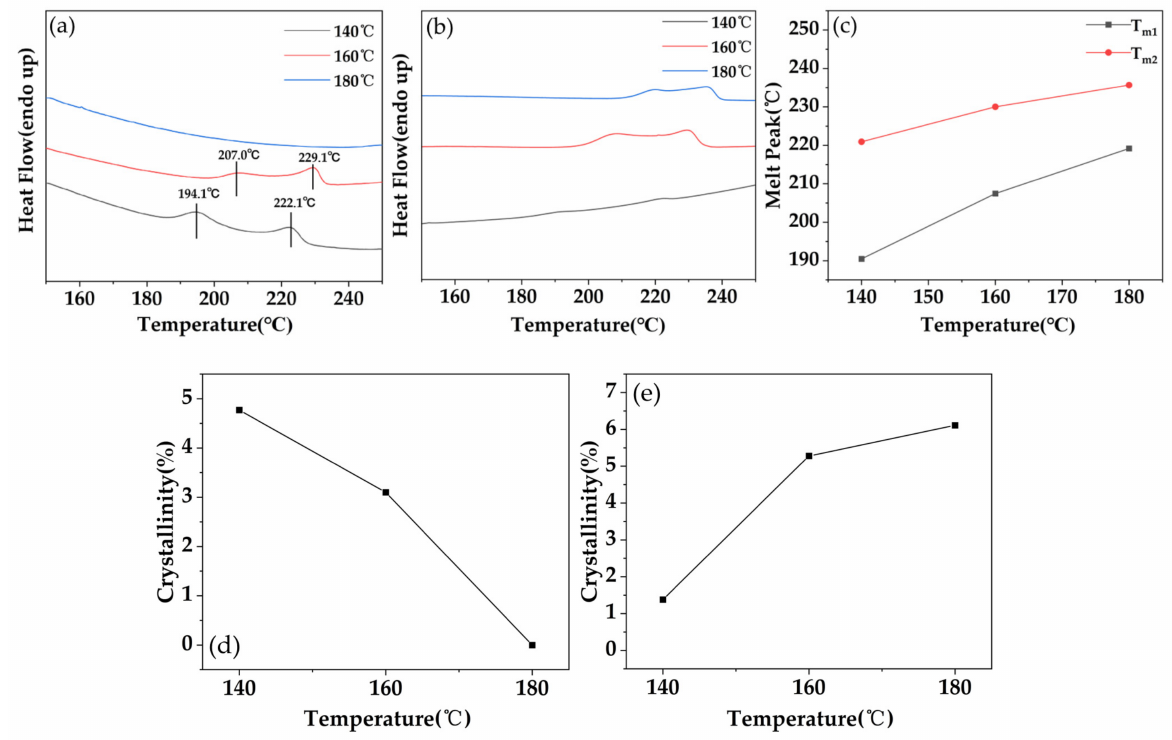
Figure 5. ( a ) DSC plot of PC, ( b , c ) DSC plot and melt peak variation of PC/GF15, ( d ) variation of crystallinity of PC, and ( e ) variation of crystallinity of